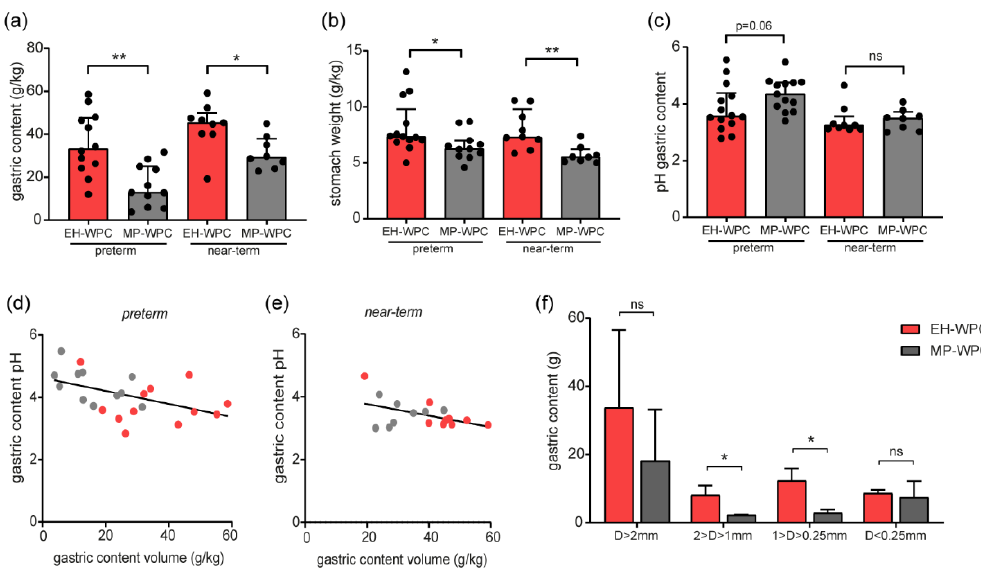
Figure 3. Digestion and coagulation in vivo. ( a ) gastric content weight and ( b ) relative weight of the empty stomach (g/kg bodyweight) were measured at day 5 during necropsy, 1 h after the last bolus of EN, with ( c ) pH levels of the gastric content. ( d , e ) correlation between gastric content volume and pH levels for ( d ) preterm and ( e ) near-term piglets. n = 14 for preterm piglets, n = 8–9 for near-term piglets. * p < 0.05, ** p < 0.01, ns = non-significant based on Mann–Whitney test between EH-WPC and MP-WPC. ( f ) Gastric content of 6 near-term piglets ( n = 3 per diet) was separated based on particle size and weight of separate fractions (g) was recorded. * p < 0.05, ** p < 0.01, ns = non-significant based on t-test between EH-WPC and MP-WPC.